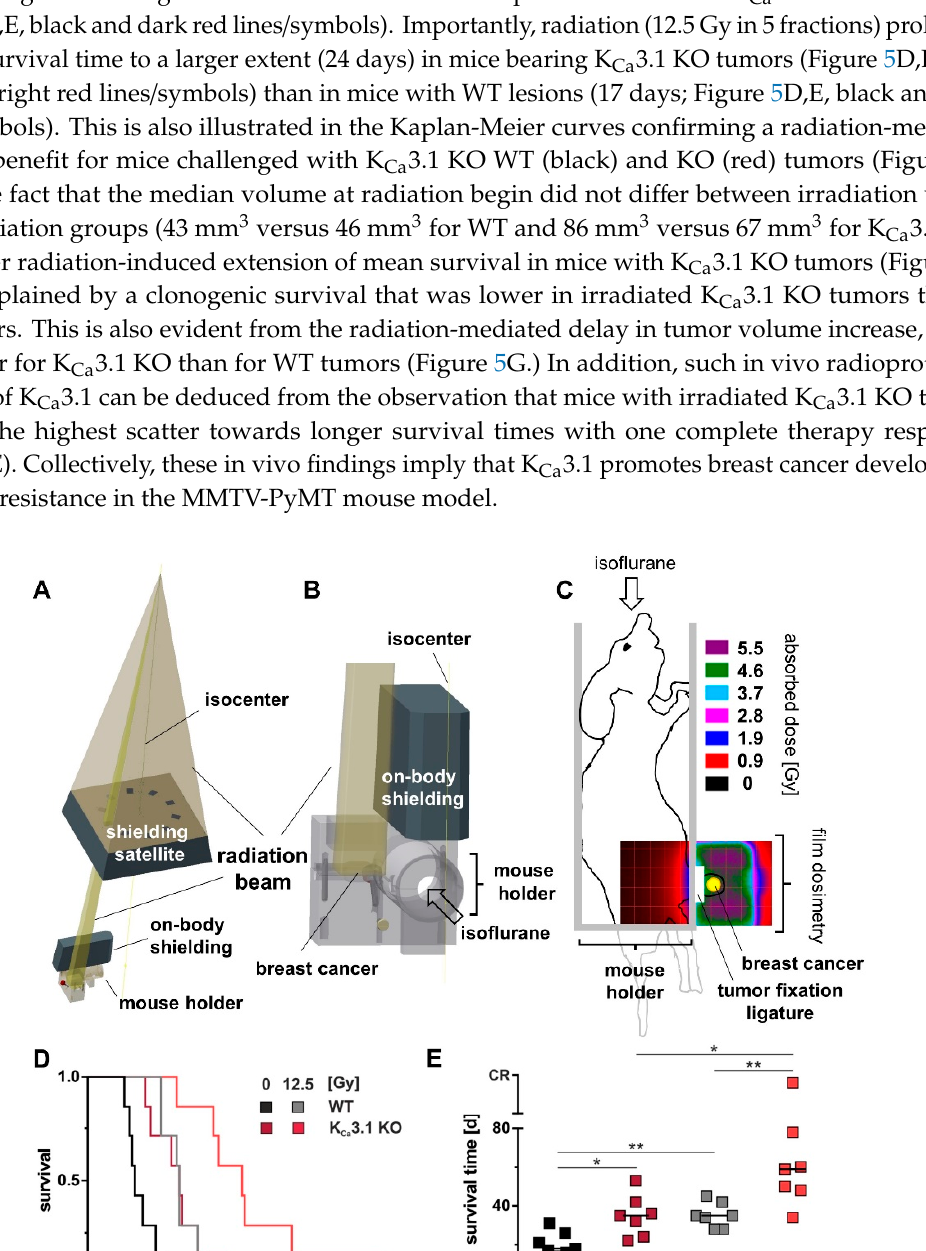
Figure 5. K Ca 3.1 channels confer radioresistance to MMTV-PyMT breast cancer in vivo . Computer- aided depiction of the irradiation setup used to locally irradiate the breast tumors. Part ( A ) represents the radiation beam (yellow gold-colored) produced by a linear accelerator and the lead shieldings. The beam is trimmed by the shielding satellite to a rectangular miniature beam which then reaches the tumor. ( B ) Beam, mouse holder, and 2nd on-body shielding in higher magnification. ( C ) Film dosimetry recorded in the coronal plane of a mouse phantom during application of 5 Gy with the setup described in A,B. Drawings of mouse and holder are superimposed. Dose distribution is given in pseudo colors. ( D ) Kaplan-Meier curves and ( E ) individual (symbols) and median (line) survival time ( n = 7) of FVB/N mice orthotopically transplanted with MMTV-PyMT WT (black/gray) or K Ca 3.1 KO (red) cells and treated with 5 fractions for a total dose of either 0 Gy (black, dark red) or 12.5 Gy (gray, bright red) starting at a tumor size of 5 mm. Compared to WT 0 Gy or 12.5 Gy, survival time was significantly prolonged in accordingly treated mice bearing K Ca 3.1 KO tumors with one complete responder (CR) in the ionizing radiation group. *, **, and *** indicate p ≤ 0.05, p ≤ 0.01 and p ≤ 0.001. Survival statistics in ( E ) are calculated from Kaplan-Meier curves in (D) by log-rank test with Bonferroni correction. ( F ) Kaplan-Meier curves showing radiation-mediated survival benefit for both genotypes as calculated by survival benefit = 1 – (survival 12.5Gy – survival 0Gy ). Normalized to non- irradiated controls was performed to present in detail the survival benefit of the respective genotypes from IR. The indicated p value was calculated by log-rank test. ( G ) Mean tumor volume (± SE, n = 7) normalized for each mouse to the volume at treatment start is plotted against the time for control (0 Gy, gray and bright red) and 12.5 Gy-fractionated irradiated (black and dark red) K Ca 3.1 WT (gray, black) and KO (bright and dark red) tumors. Two-way ANOVA and Tukey´s test compared to WT 0 Gy with ** and *** indicative for p ≤ 0.01 and p ≤ 0.001.